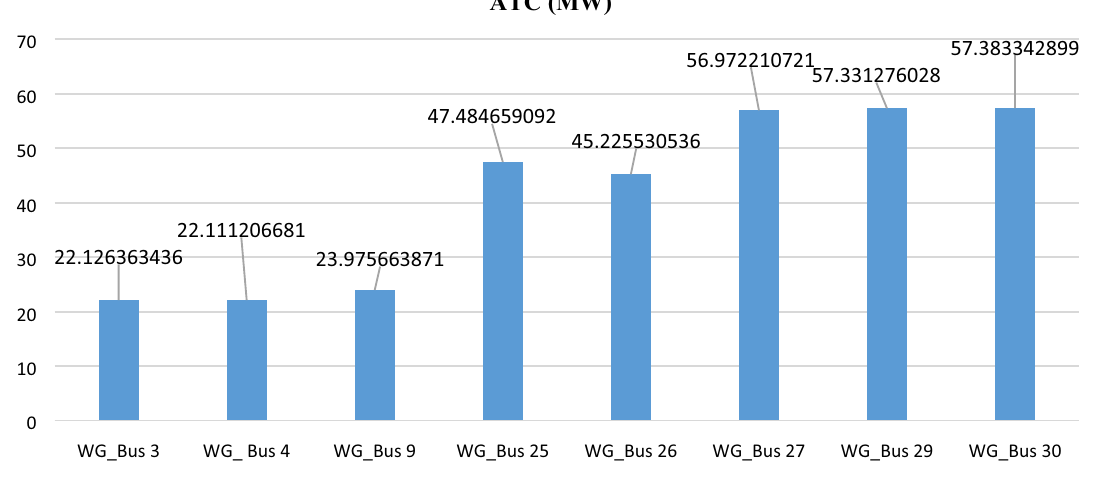
Fig. 5 ATC in limiting line due to WG at different bus location in Zone